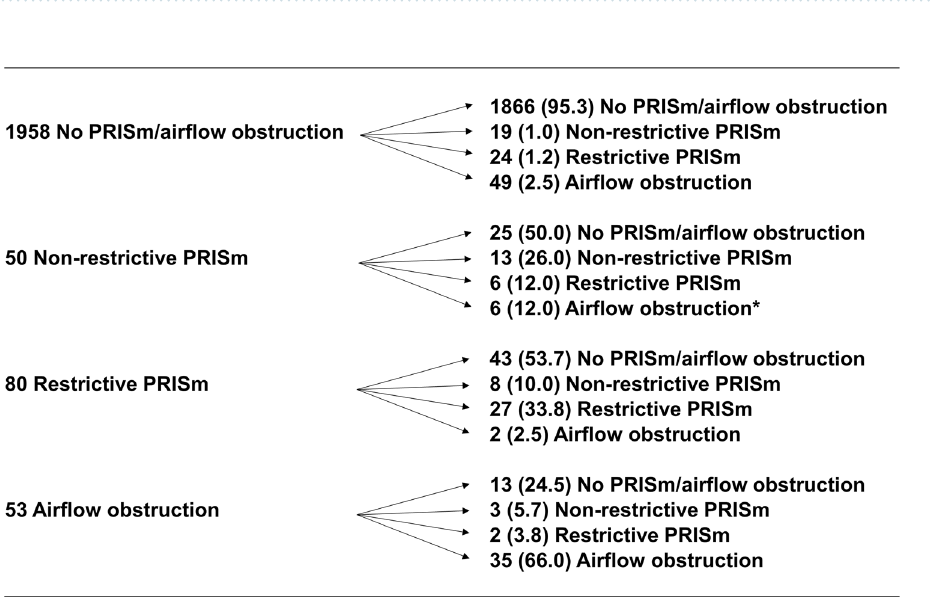
Figure 3. Transitions of lung function categories among participants between first visits and visits after five years. Variables are presented as No. (%). * P < 0.017 versus no PRISm/airflow obstruction by chi-square test. PRISm—preserved ratio impaired